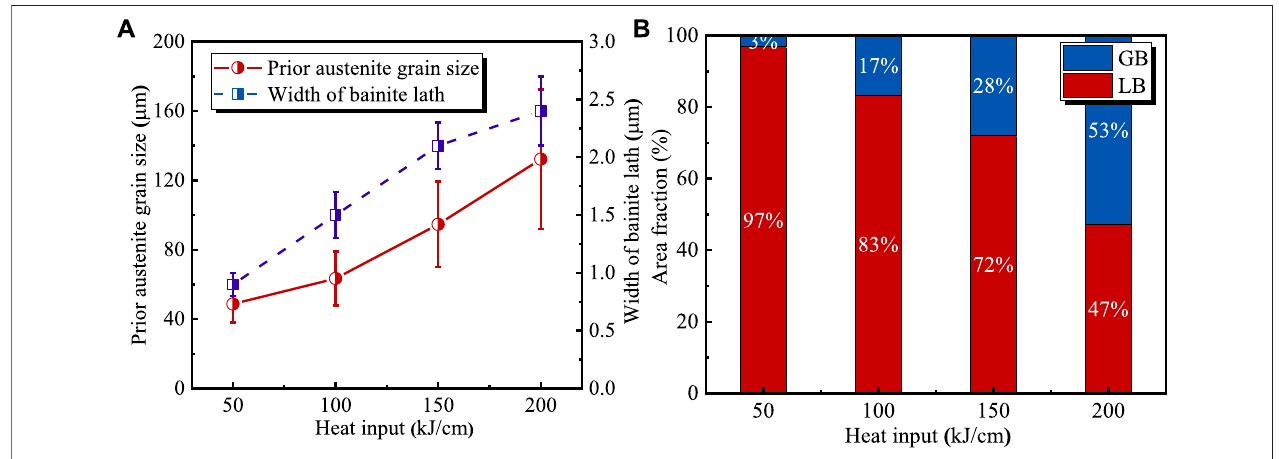
FIGURE 6 | (A) Prior austenite grain size and width of the bainite lath and (B) the area fractions of LB and GB in the CGHAZ at different heat